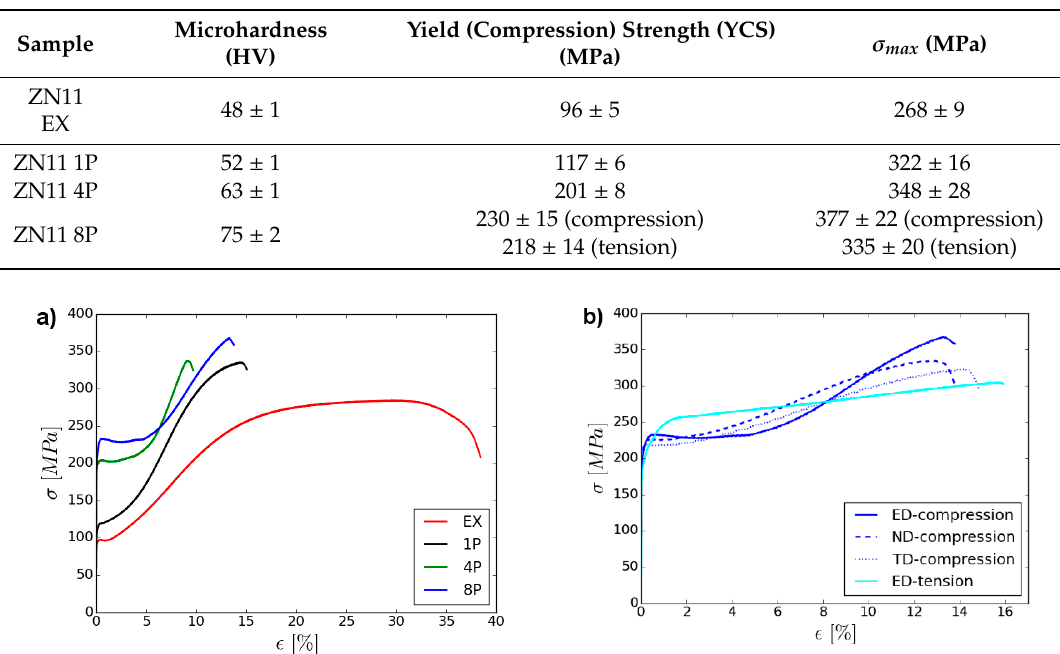
Figure 8. True stress–true strain compression curves of ( a ) all investigated conditions measured along the processing direction (extrusion direction (ED)) and ( b ) of the 8P sample measured in ED, normal direction (ND), and transverse direction (TD), see Figure 1.